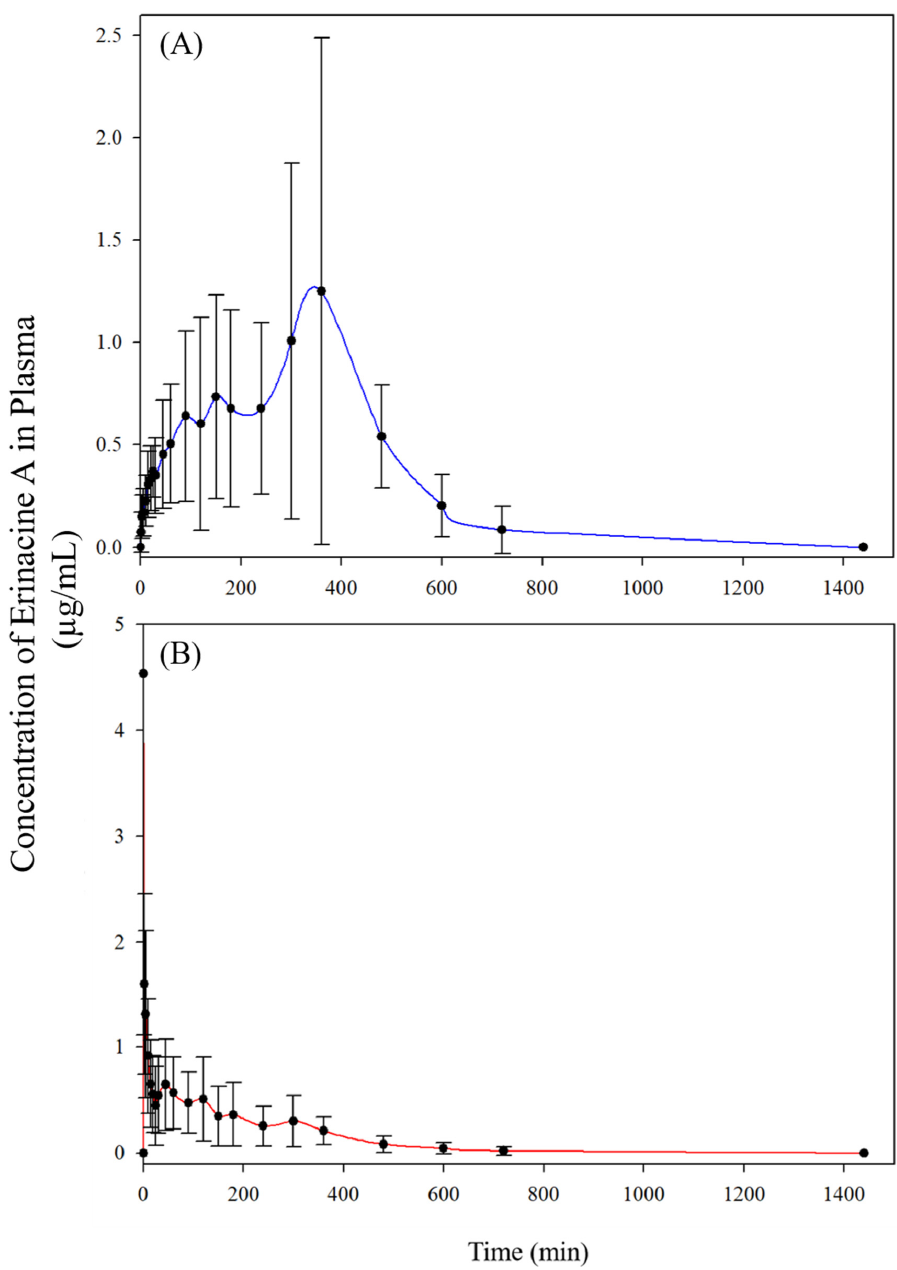
Figure 3. Plasma concentration–time curves of erinacine A in rats after ( A ) oral administration of H. erinaceus mycelia extract at 2.381 g/kg BW (equivalent to 50 mg/kg BW of erinacine A), and ( B ) intravenous administration of erinacine A at 5 mg/kg BW. Values are means ± SD (n = 6).